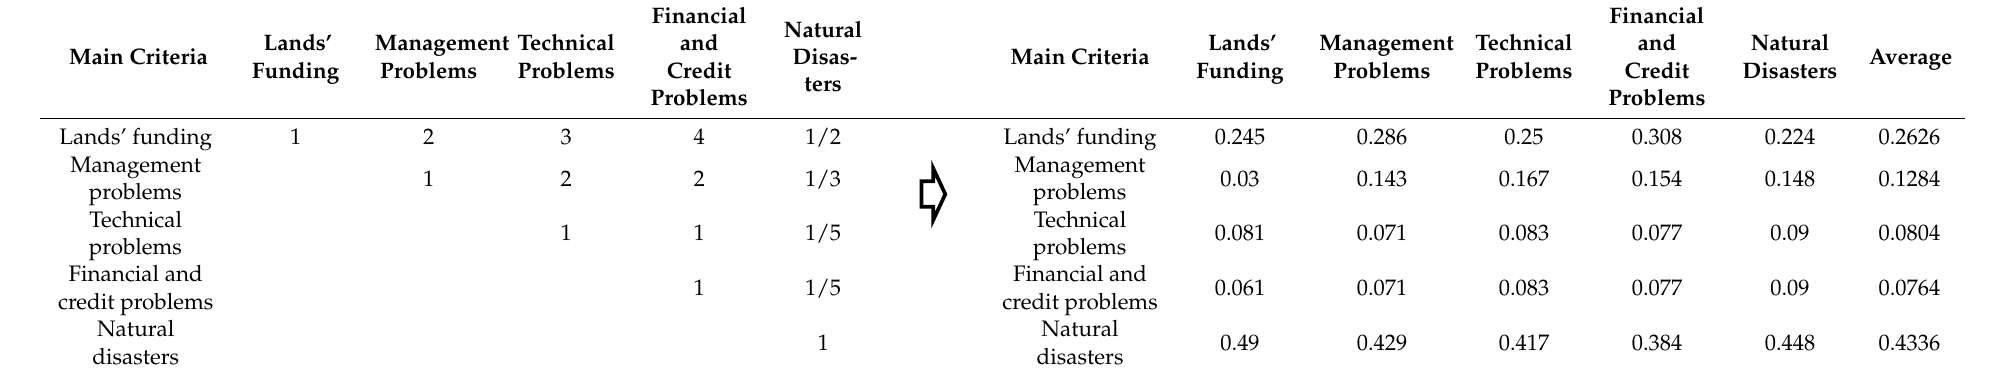
Table 3. The pairwise comparisons matrix for main criteria. Table 4. The pairwise comparisons matrix for lands’ funding.